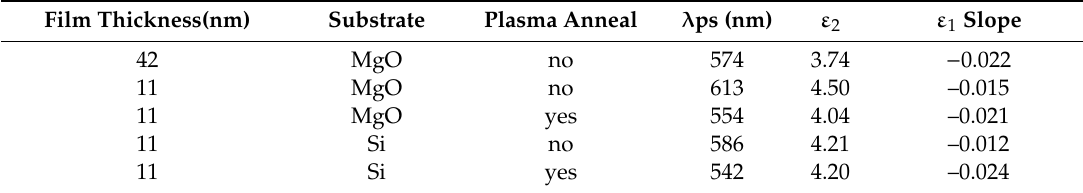
Table 1. Summary of plasmon resonances and ε 2 values for PE-ALD TiN on MgO and Si substrates.